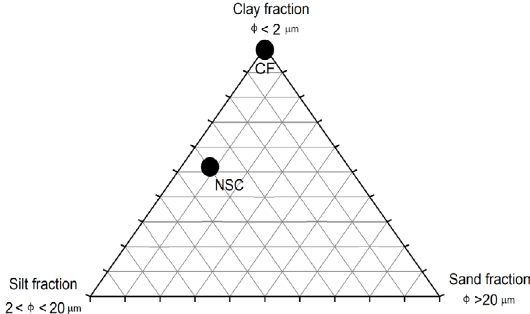
Figure 1. Clay body particles sizes